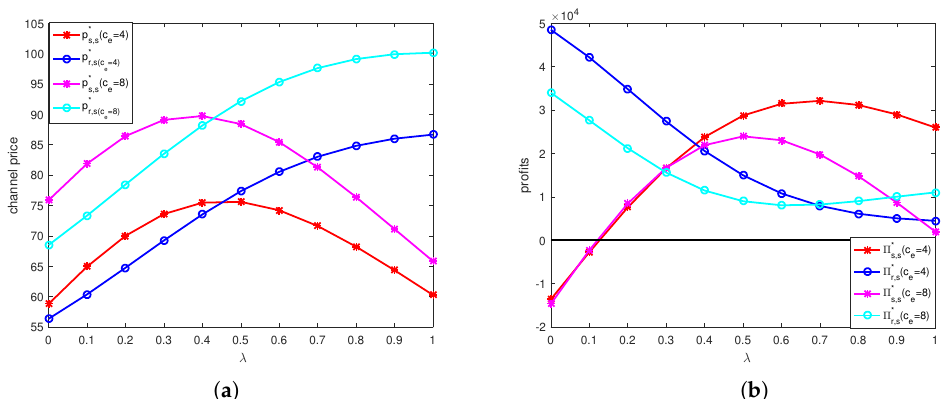
Figure 4. Optimal selling price and profit under online channel price discount contract: ( a ) Optimal selling price. ( b ) Optimal profit.